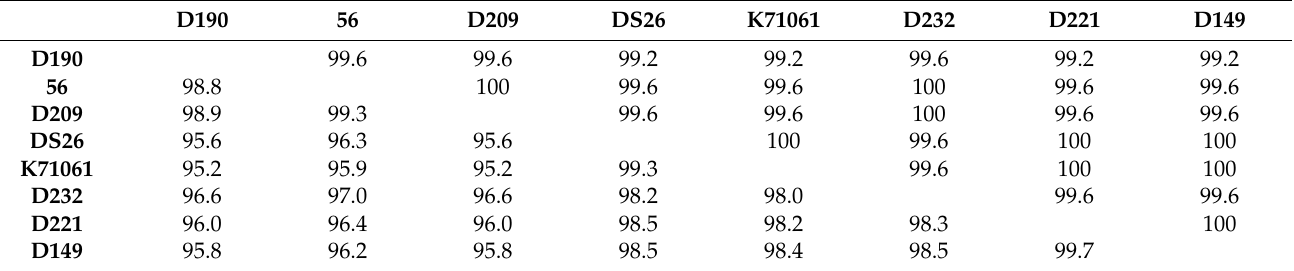
Table 3. Percentage identity between PCV isolates in the NS5 region amplified by FU2/cFD3 primers. Top right half displays amino acid identities (252 amino acid-long alignment), bottom left half displays nucleotide identities (737 nucleotide-long alignment). The names of isolate from this study start with a